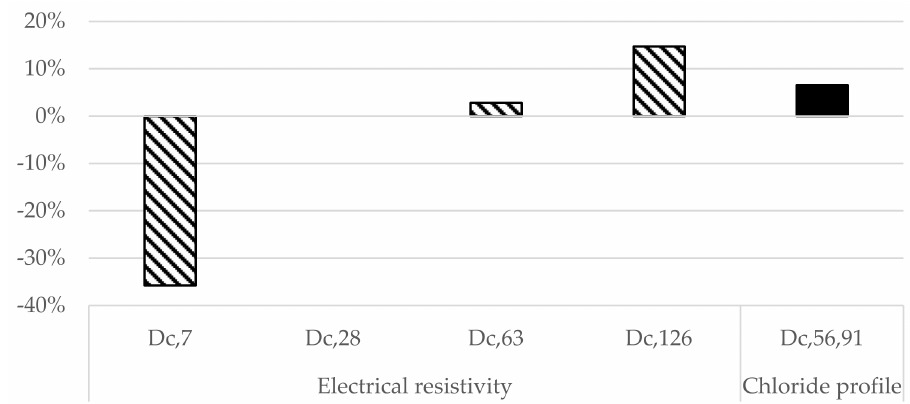
Figure 4. Percentage differences in diffusion coefficients compared with D c,28 .